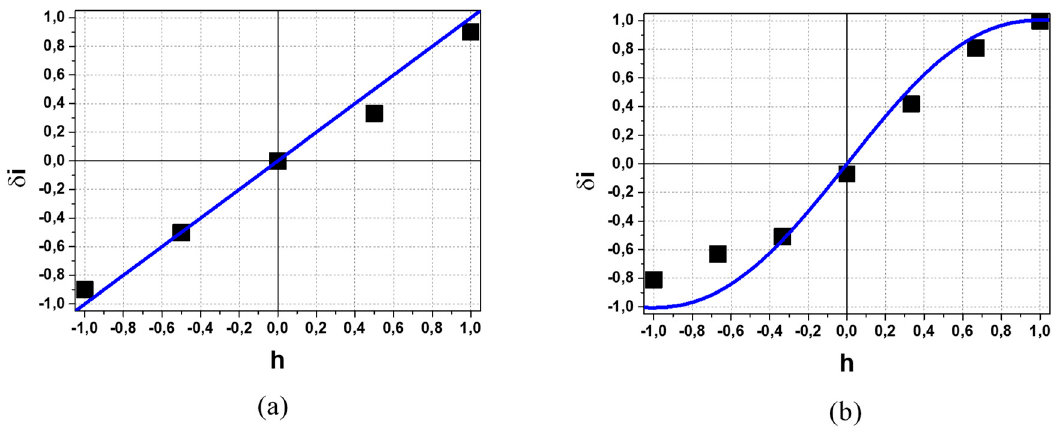
Figure 15. δ i - h transfer characteristics of the secondary Xe ++ beam for 90° CEA operation in normal ( a ) and 2-times deceleration ( b ) mode.